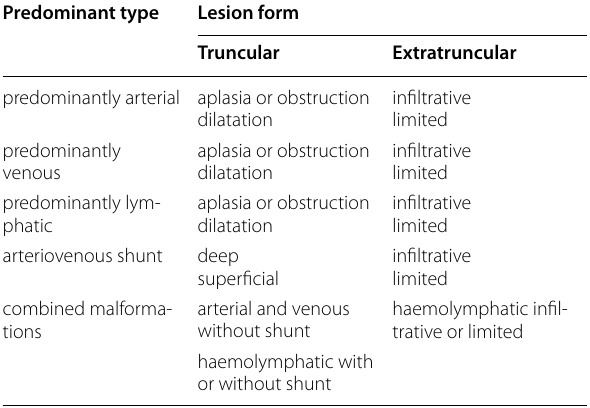
Table 5 Diagnostic tools before and during treatment